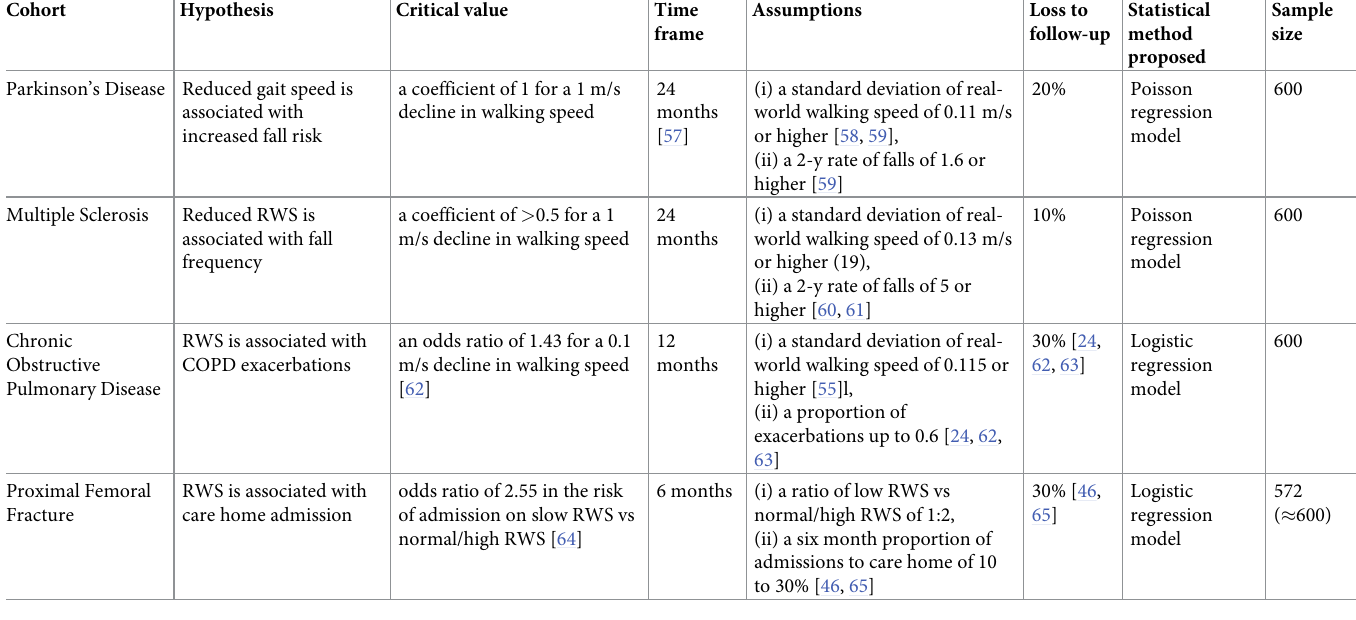
Table 2. Cohort specific sample size